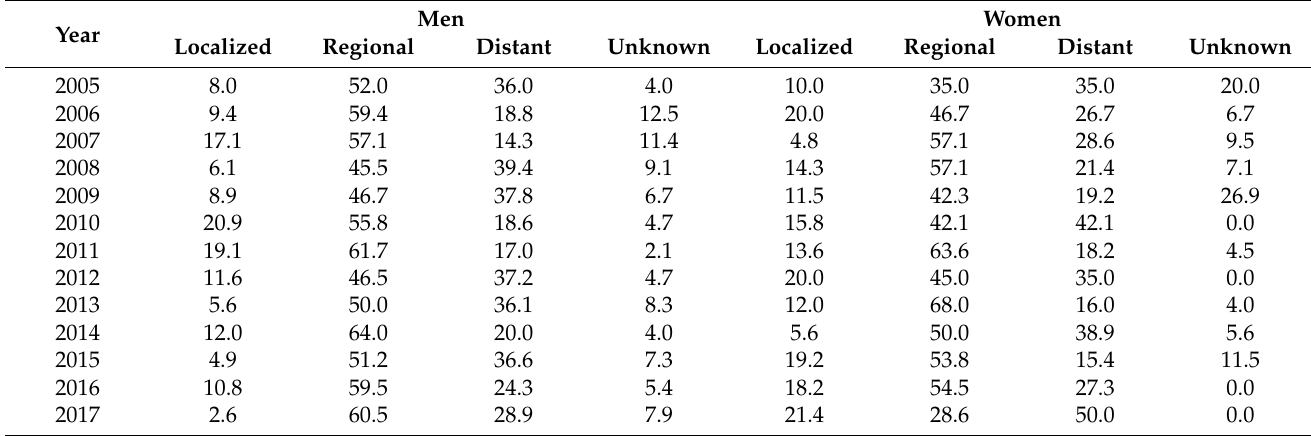
Data are presented as %. SEER = Surveillance, Epidemiology, and End Results.